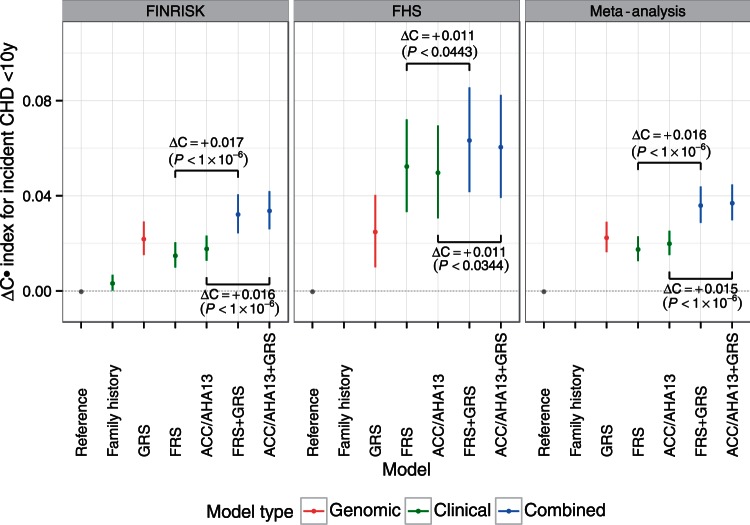
Difference in C-index (95% CI) for time to incident CHD
event within 10 years, relative to the reference model in the FINRISK
and FHS cohorts. Reference models used age as the time scale, stratified
by sex (FINRISK: adjusted for cohort and geographic location; FHS:
adjusted for cohort). Family history was not available for all of the
FHS cohorts and thus not considered here. P-values are
from the correlated jackknife test.